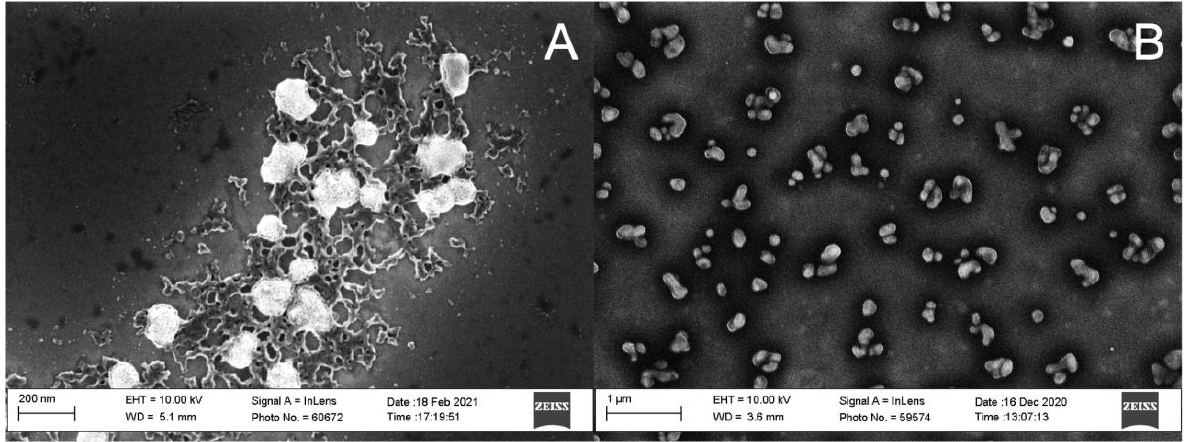
Figure 6. Scanning electron microscope images of alginate nanoparticles synthesized using enzyme- digested alginate with the ionic gelation method. ( A ) 0.10 mg/mL alginate and 0.10 mg/mL Ca 2+ homogenized with a bath sonicator (IG10). ( B ) 0.10 mg/mL alginate and 0.10 mg/mL Ca 2+ homoge- nized with a magnetic stir plate at 1300 rpm (IG5).